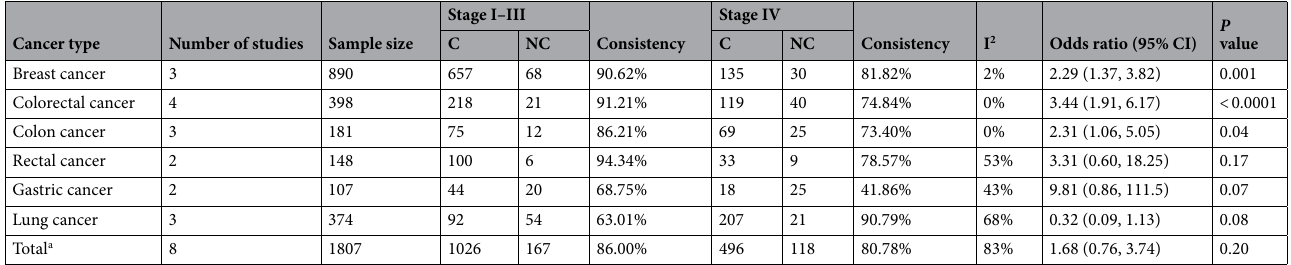
Table 2. Meta-analysis results of consistency between WFO (‘Recommended’ or ‘For consideration’) and MDT for patients with various cancers in stages I–III and IV. C Concordance cases, NC nonconcordant cases. a The number of rectal cancer and colon cancer, which overlaps with colorectal cancer, has been excluded from the total. In addition, the total includes the number of ovarian cancer and cervical